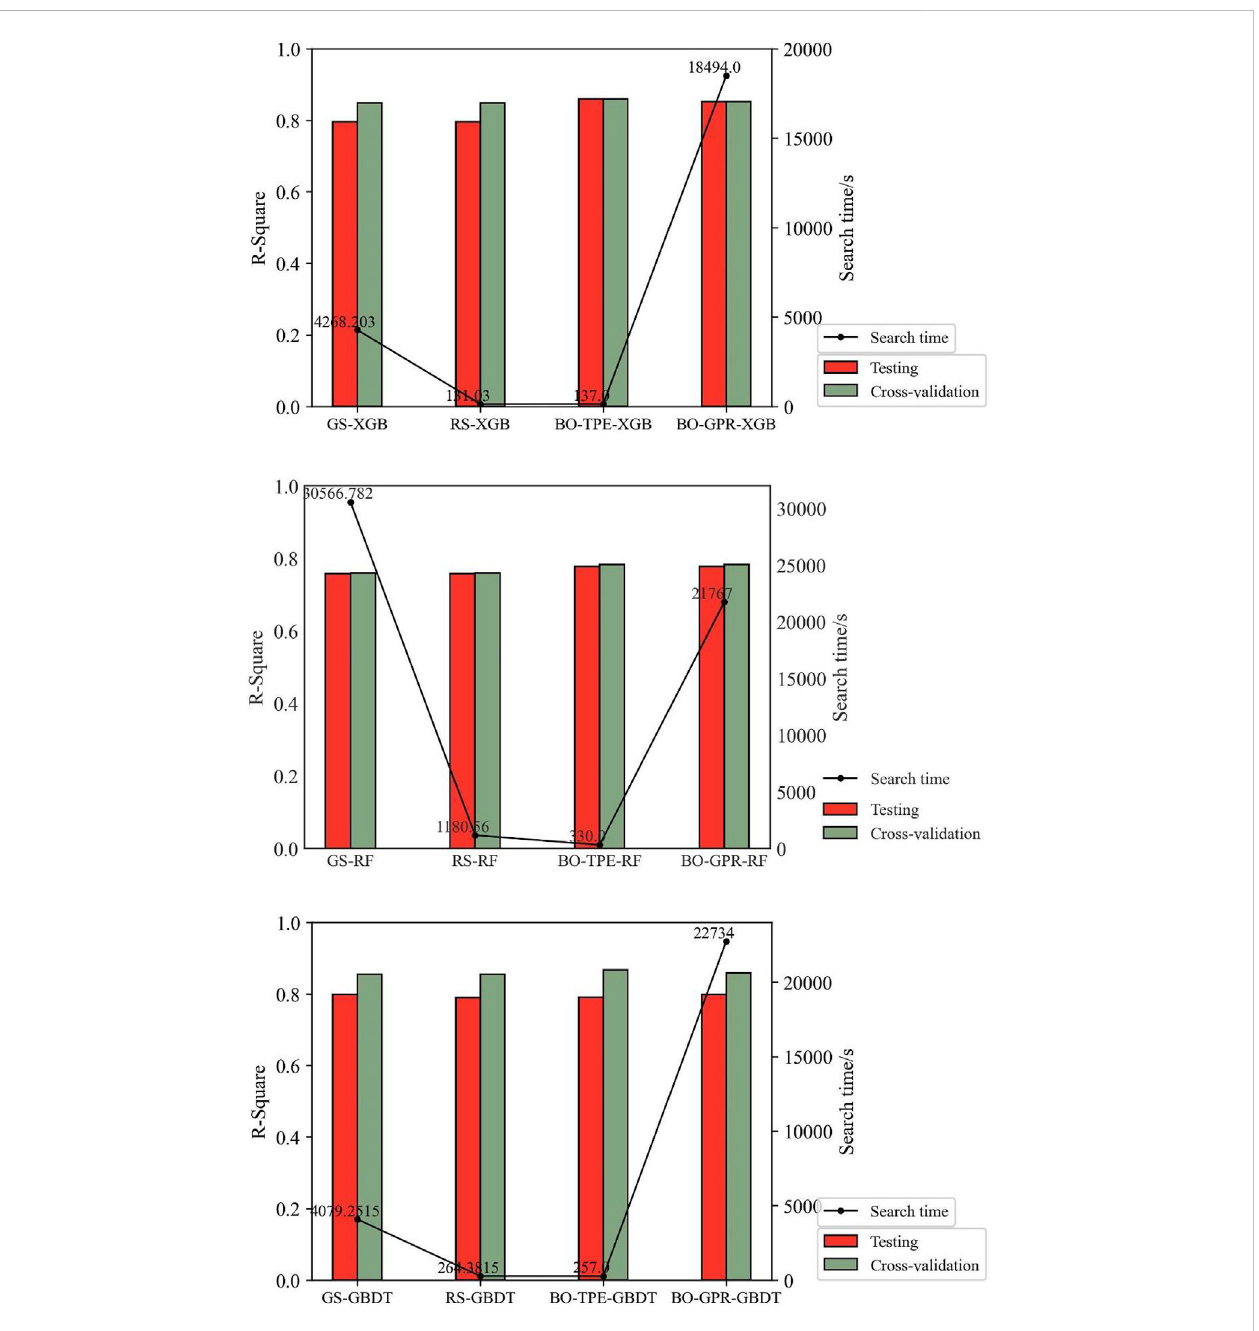
FIGURE 9 Optimization Effect of Hyperparameter con fi guration Method in Different Models.